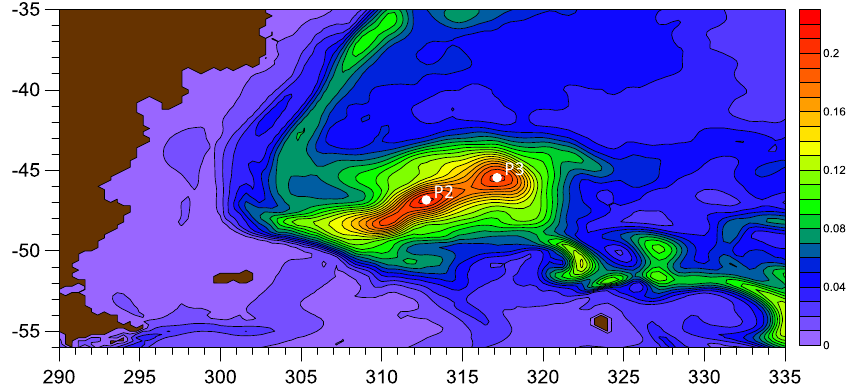
Fig. 12. Rms of the high-frequency SSH signal (in m) in the Argentine Basin.